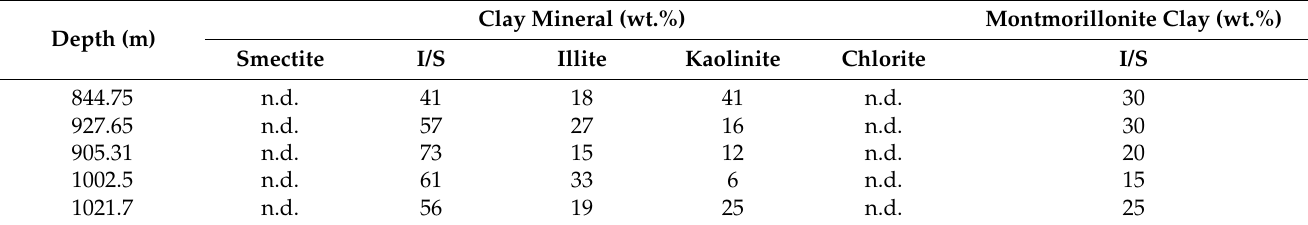
Table 6. Quantitative X-ray diffraction analysis of clay minerals.